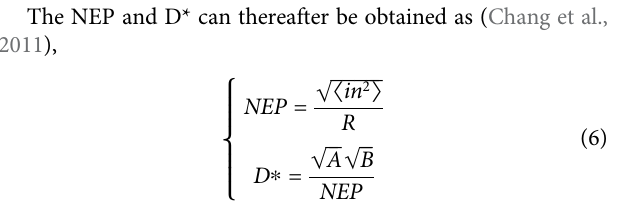
FIGURE 4 | Noise power spectra of the MoTe 2 – WS 2 – MoTe 2 heterojunction APD under different applied bias voltages. The black straight linesarelinear fi ttingsofthenoisepowerspectraunderdifferentbiasvoltages.